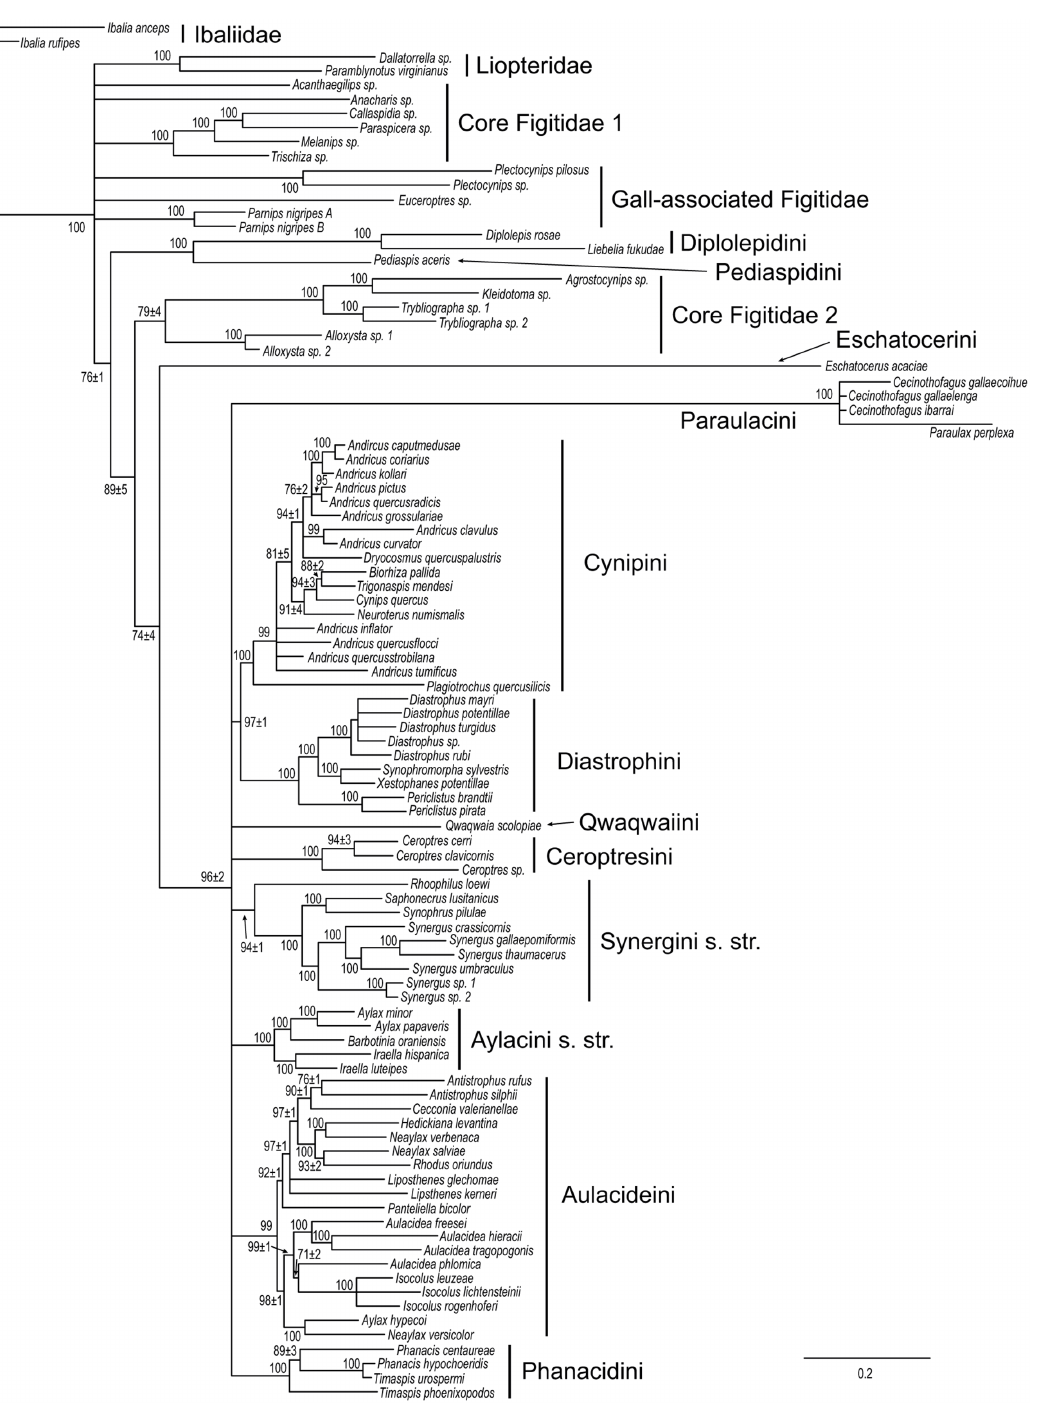
Fig 3. Results from analysis of the combined molecular data. Numbers on branches indicate posterior clade probabilities (in % units) ± Monte Carlo error (error smaller than 1% not shown)across four separate analyses. Only groups with posterior probability above 70% shown.